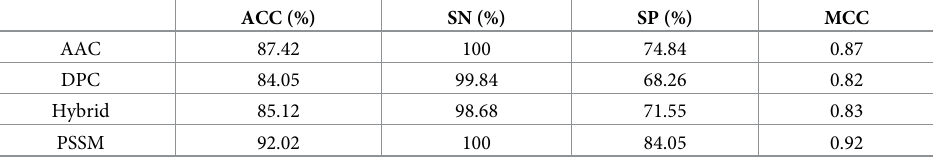
Table 2. The performance of SVM models using AAC, DPC, Hybrid and PSSM profiles on the original